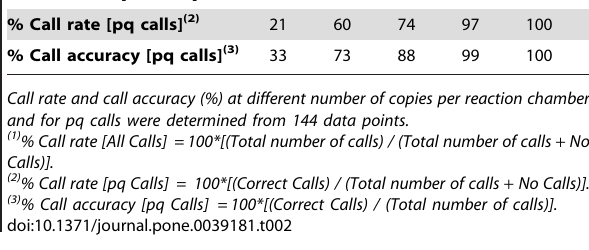
(rs513349, PN: 4351376) containing two different probes (FAM- MGB and VIC-MGB) targeting a single SNP on different alleles was purchased from Applied Biosystems, Foster City, CA.